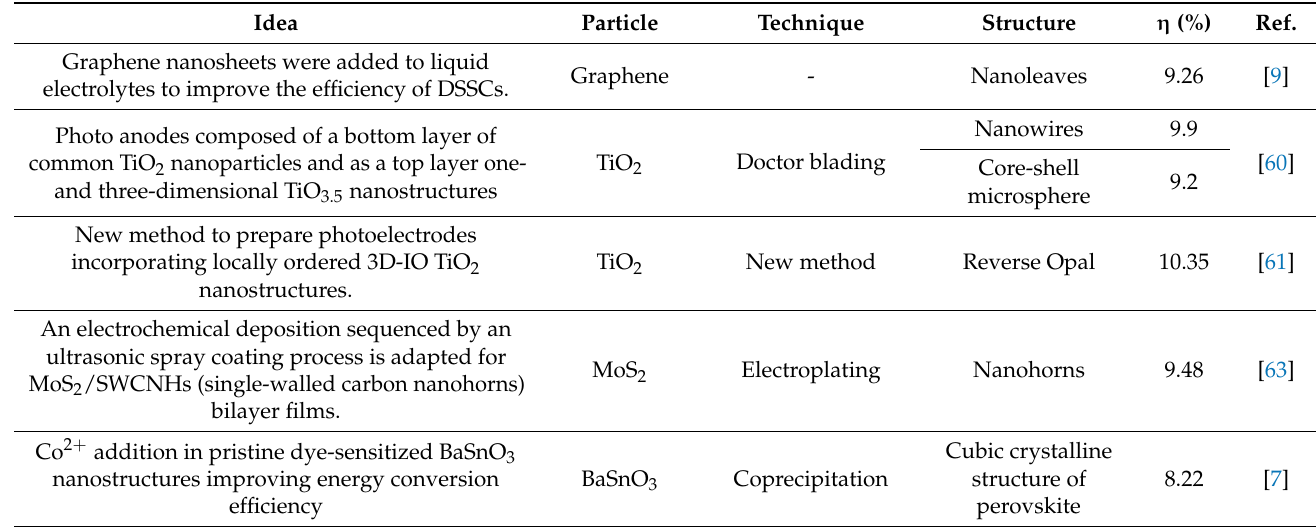
Table 5. Nano-DSSC structures higher